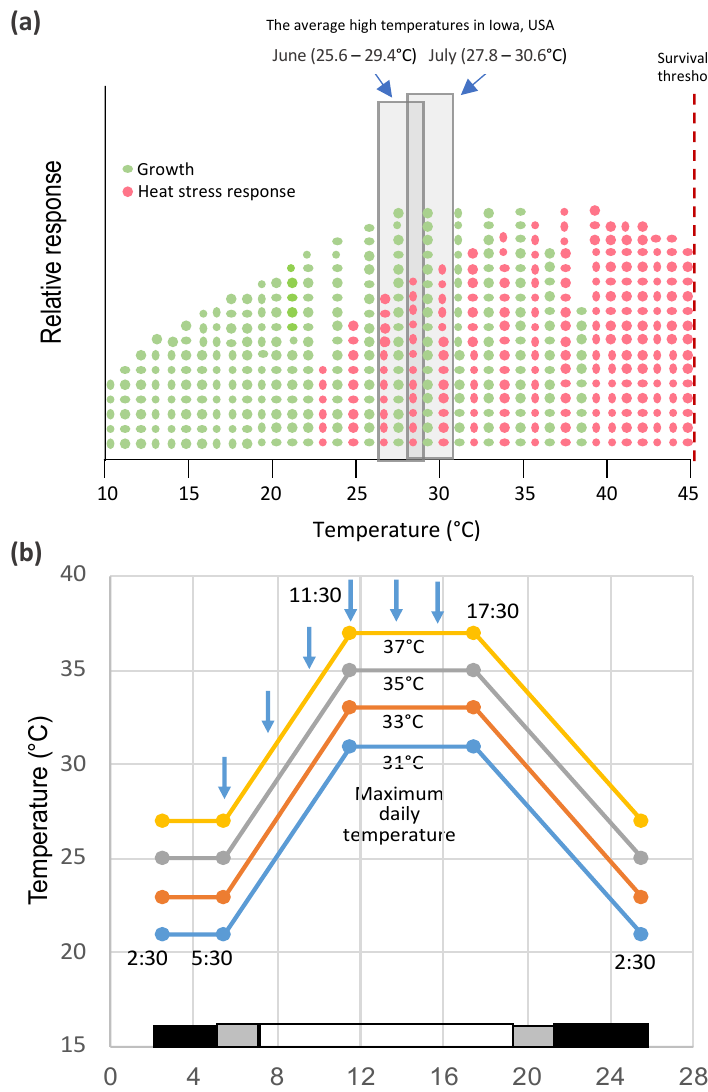
1Zeitgeber Time (hr) Figure 1. The relationship of temperature, growth, and heat stress in maize. ( a ) Optimal growth conditions overlap with heat stress. The optimal temperature range for maize growth is 25–33 ◦ C, day/17–23 ◦ C, night (https://www.extension.purdue.edu/extmedia/nch/nch-40.html), which are mid-summer temperatures in the US corn belt. The box indicates the average high temperatures (maximum daily temperatures) in June and July in Iowa, USA, a region representing an ideal climate for maize production. The trends shown here are from experiments conducted with the maize inbred line W22 grown under controlled environment conditions in the Enviratron at Iowa State University [14]. ( b ) An example of the temperature conditions used in the Enviratron to simulate diurnal temperature cycles under field conditions. Note the ramping up of the temperature to different maximum daily temperatures in the virtual afternoon and the ramping down in the virtual